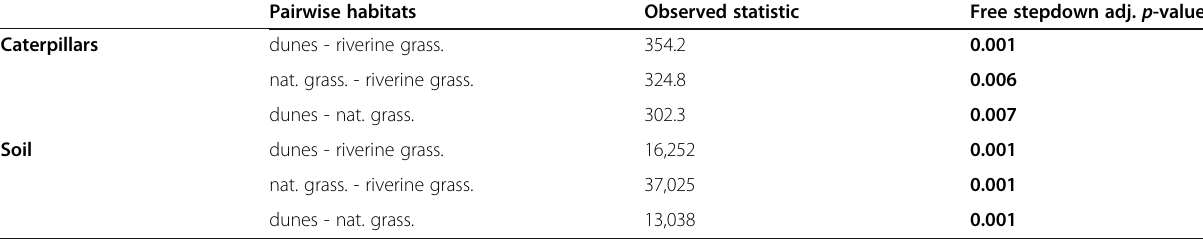
Table 2 Pairwise comparisons of microbial composition within habitats